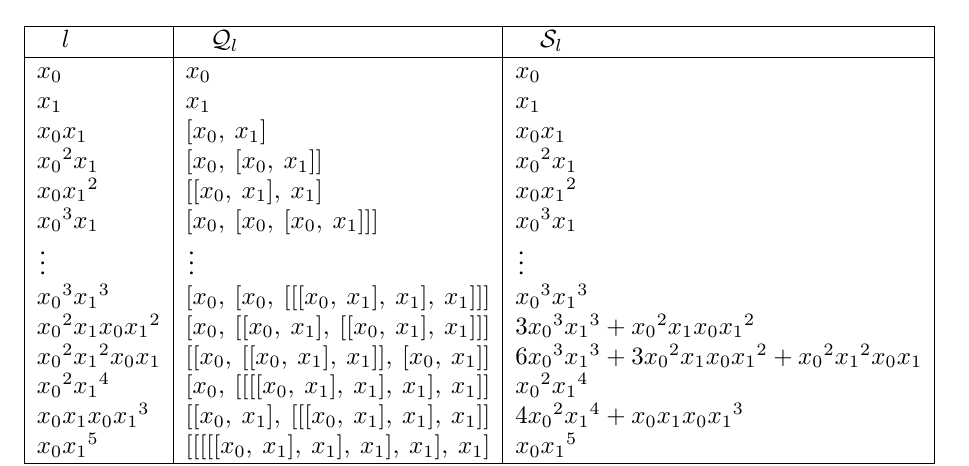
Algorithmic and combinatoric aspects of multiple harmonic